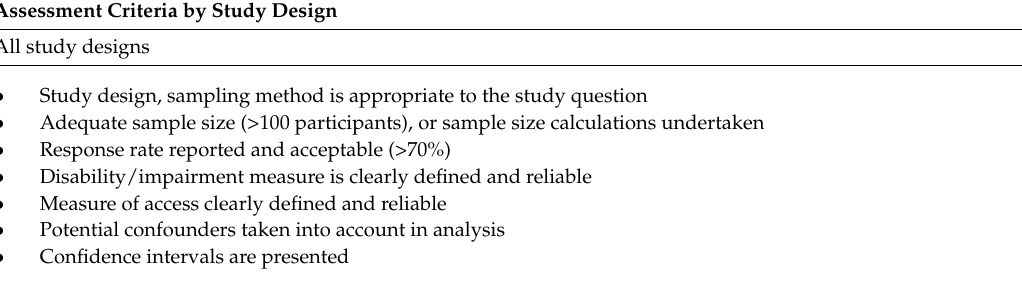
Table 1. Quality assessment criteria and